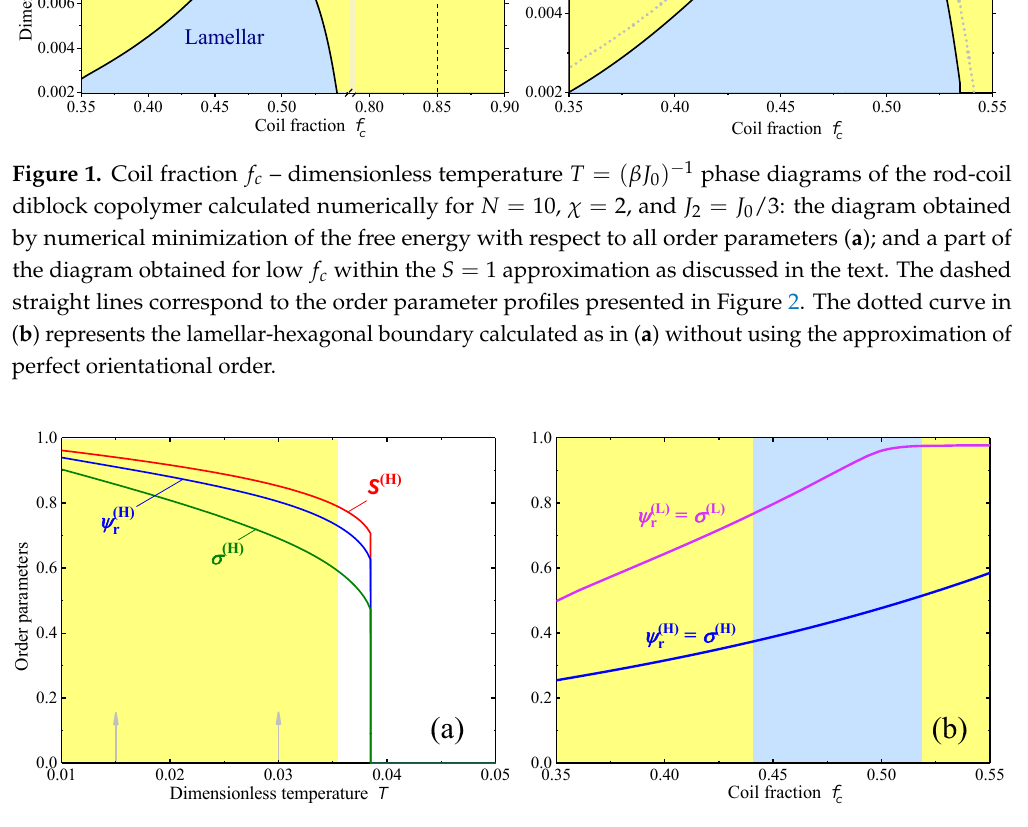
Figure 2. Variations of the orientational and translational order parameters across the phase diagrams shown in Figure 1: order parameters of the hexagonal phase as functions of the dimensionless temperature for f c = 0.85 (along the vertical dashed line in Figure 1a) ( a ); and the translational order parameters of the lamellar and hexagonal phases as functions of f c resolved within the S = 1 approximation for T = 0.06 (along the horizontal dashed line in Figure 1b) ( b ). The background colors indicate the regions of stability of the corresponding phases as in Figure